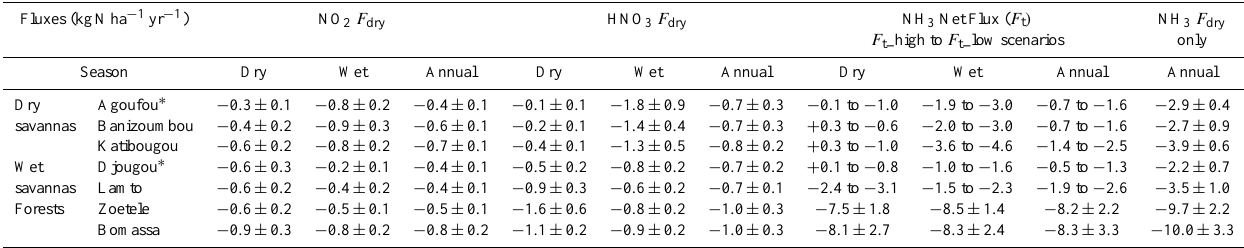
Table 5. Mean seasonal and annual dry deposition fluxes and standard deviation ( F dry ) of NO 2 and HNO 3 as well as NH 3 net bidirectional fluxes ( F t , from high to low scenario estimates) at IDAF sites of west and central Africa over the period 1998–2007. Annual NH 3 dry deposition fluxes are added for comparison. Fluxes are expressed in kgNha − 1 yr − 1